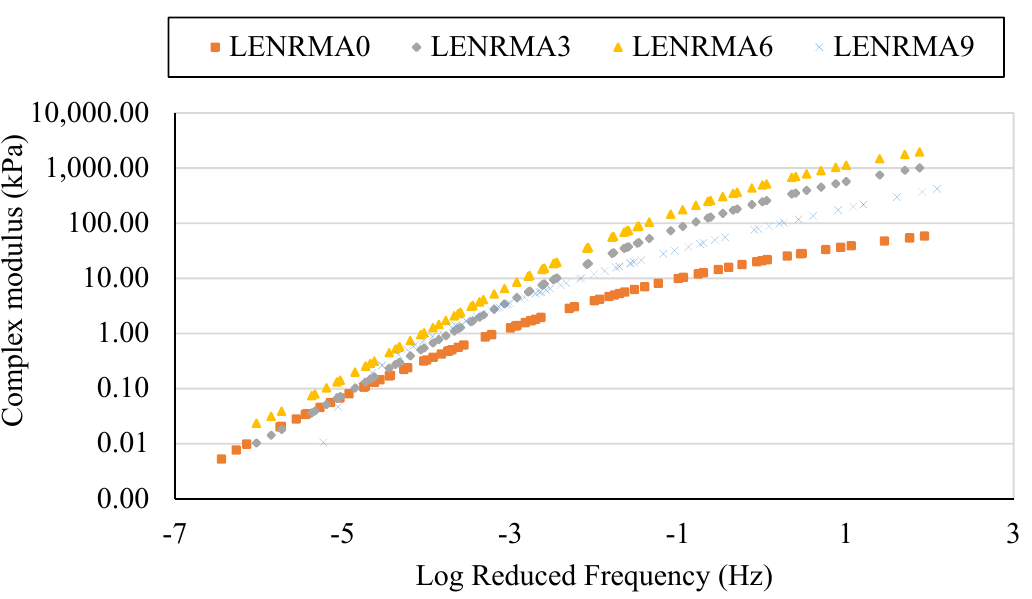
Figure 12. Complex modulus master curve for LENRMAs at a ref. temperature of 25 °C.